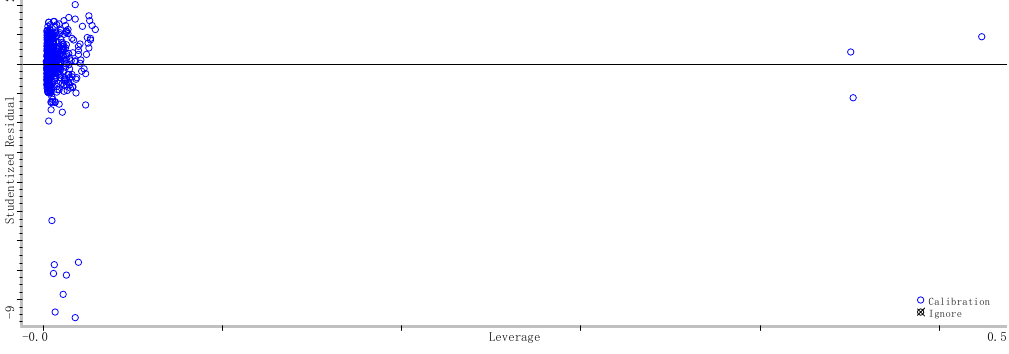
Figure 6. Outlier sample rejection for larch by TQ software.